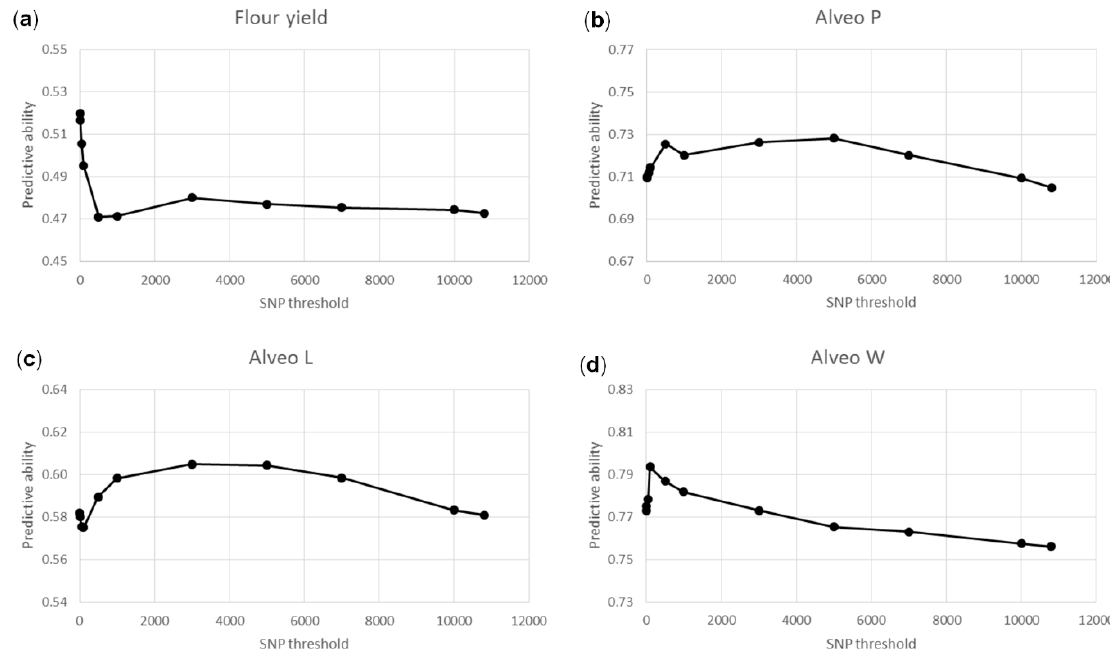
Figure 8. Predictive abilities based on genomic feature models with two G-matrices. The two G-matrices were computed from significant and nonsignificant SNPs, respectively. Half of the lines were used for GWAS to select significant SNPs, and the other half were used for LOO cross-validations. The threshold for number of significant SNPs was from five to 10,802. ( a ): Flour yield, ( b ): Alveo P, ( c ): Alveo L, ( d ): Alveo W.